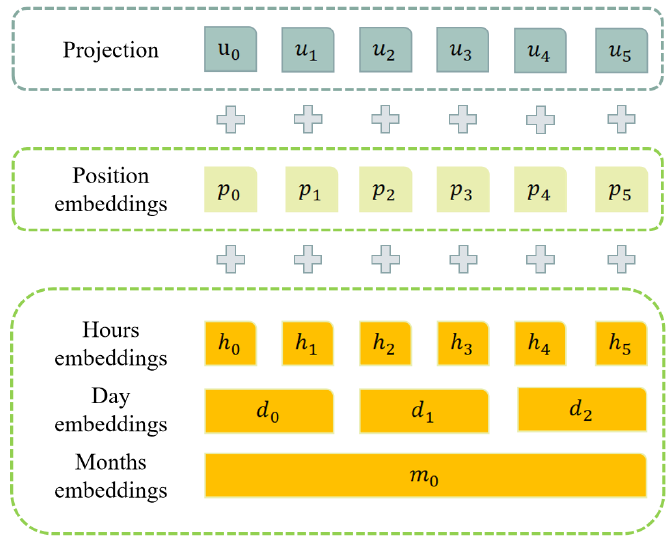
Figure 5. The input representation of the Informer